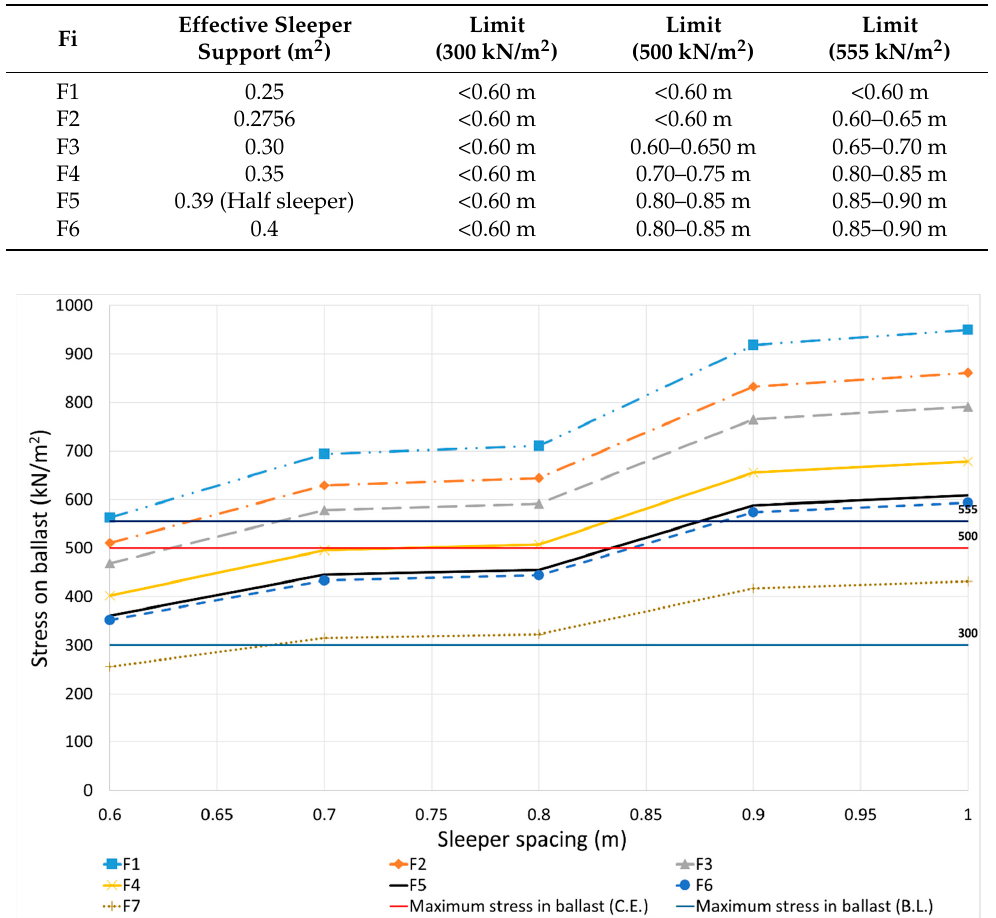
Figure 11. Maximum allowed shear stress and bending stress in rails according to Table 7 values. Table 8. Effective support area Fi considered of sleepers to calculate stress on ballast (Figure 12).